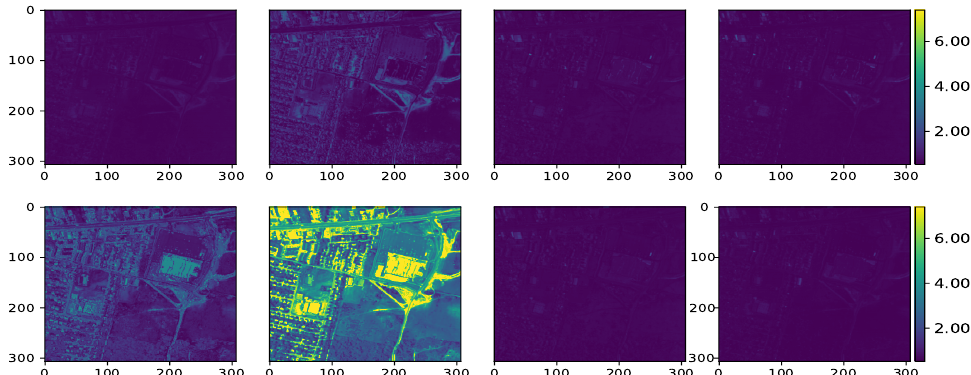
Figure 13. Maps of reconstruction error of the Urban data. From upper left to right: VCA-K-Hype, N-FINDR-NDU, rNMF, DAEN. From bottom left to right: CYCUNET, Pixel-based DCAE, Modified Pixel-based DCAE, and the proposed method, respectively.